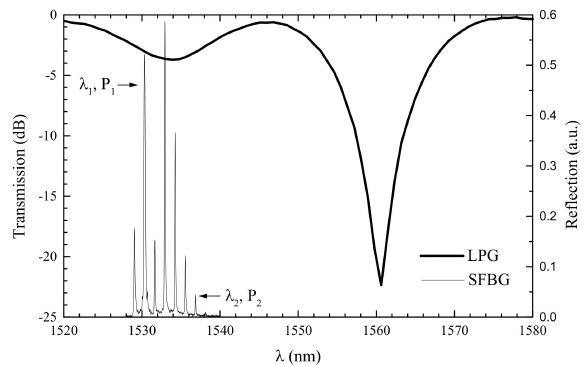
Figure 19. LPFG transmission spectrum and reflection spectrum of the sampled-FBG. Reprinted with permission from [151]. © 2021